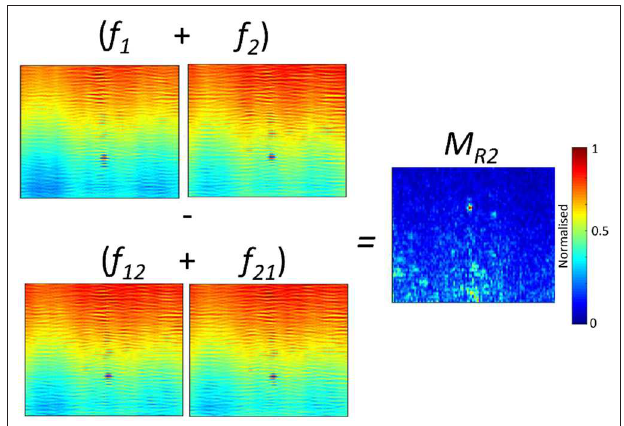
FIGURE 1 | Summary of dual frequency modulation calculation for M R 2 .